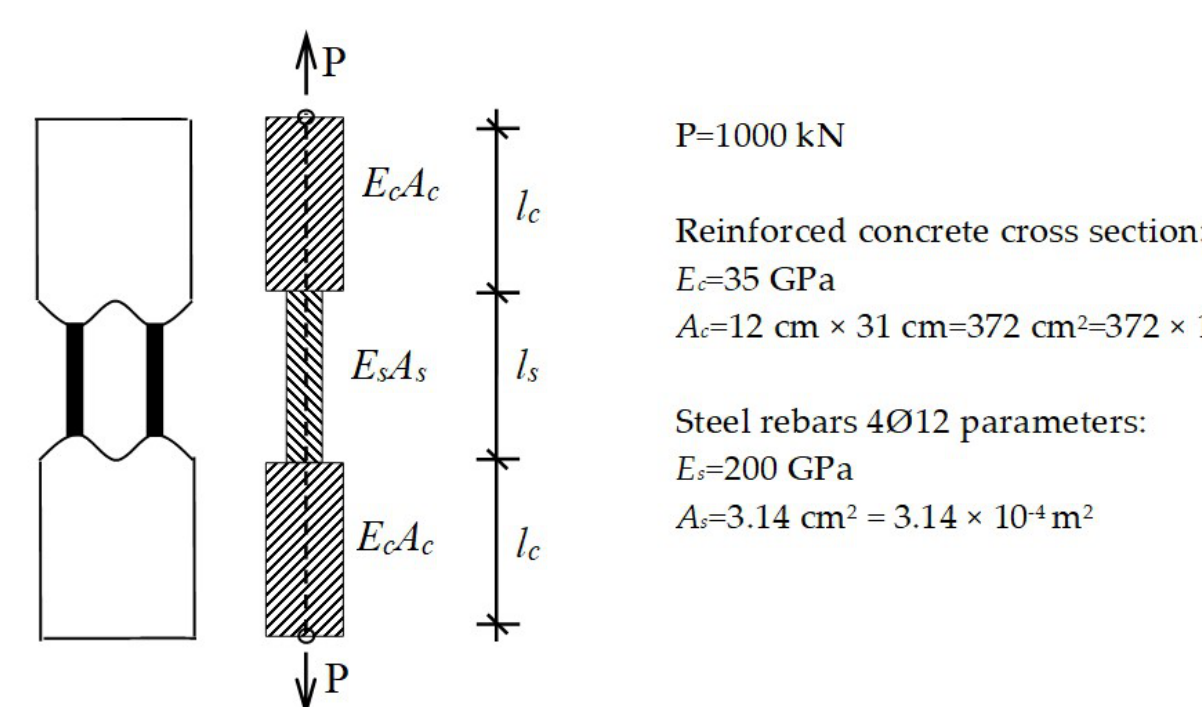
Figure 4. Calculation model of the column—single multi-area element.